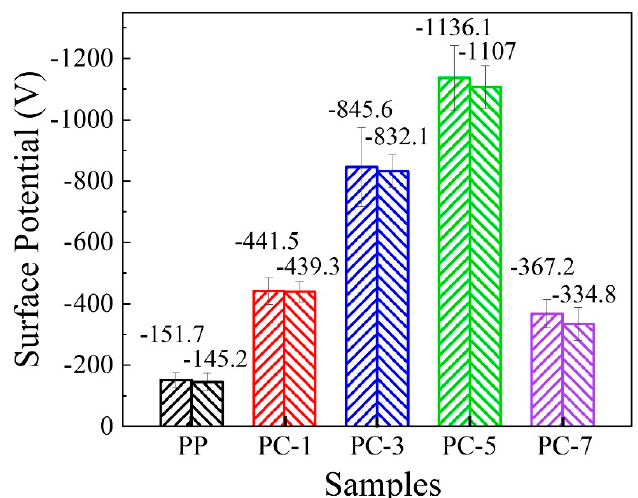
Figure 10. Surface potential of the PP / PC meltblown membranes after initial and indoor storage for 30 days.